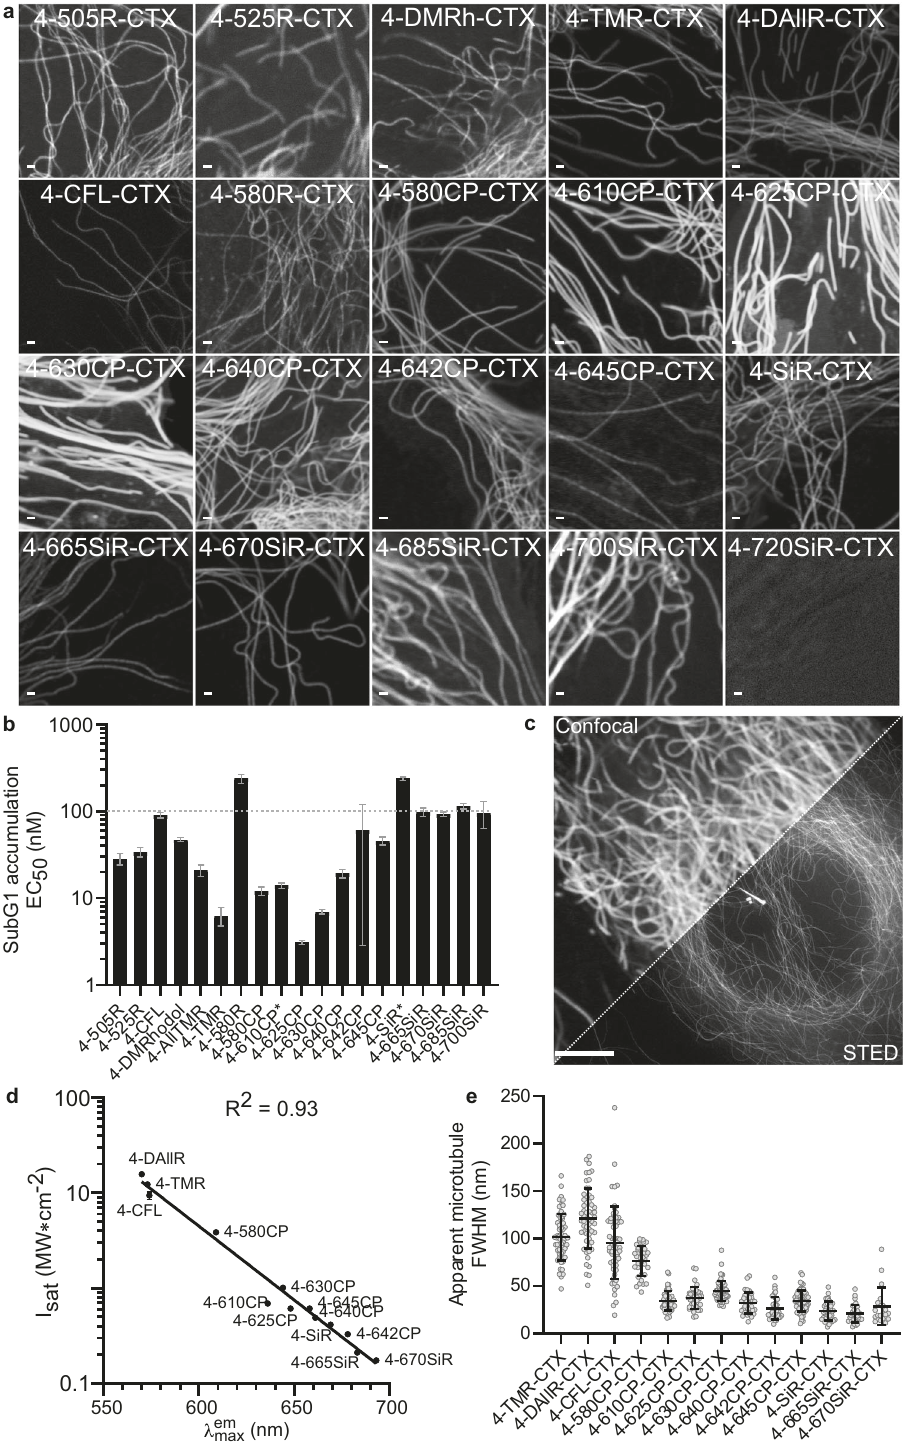
Fig. 5 | Properties of fl uorescent tubulin probes. a Confocal images of micro- center. Scale bar, 5 µ m. d Plot showing the correlation of the stimulated emission tubules in living human fi broblasts under no-wash conditions. Scale bar 1 µ m. ef fi ciency ( I sat ) and emission maximum ( λ em max ) of the fl uorophore. I sat values b Toxicity of tubulin probes for HeLa cells after 24h of incubation. *EC 50 of 4- represented fi tted value with±SEM, fi tting is shown in Supplementary Fig. 23o 610CP-CTX ( 55 ) and 4-SiR-CTX ( 61 ) was measured in ref. 22 . Data represented as ( n =3 independent experiments). Goodness of linear fi tting is estimated by pro- fi tting of data fi tted half maximal effective concentration (EC viding a coef fi cient ofdetermination ( R 2 ). e Measured of apparent microtubulefull 50 ) value with±SEM, points is shown in Supplementary Fig. 19c ( n =3 independent experiments). widthathalf maximum (FWHM) inSTED mode with a 775nm depletion laser setat c ConfocalandSTEDmicroscopyimageofhuman fi broblastsstainedwith10nM4- 56MW/cm 2 , except 4-670SiR-CTX ( 63 ) was imaged using 28MW/cm 2 . Data repre- sent the mean±SD ( N =30). Source data are provided with this 625CP-CTX ( 56 ) probe. Note, centrosome and primary cilium are visible in the